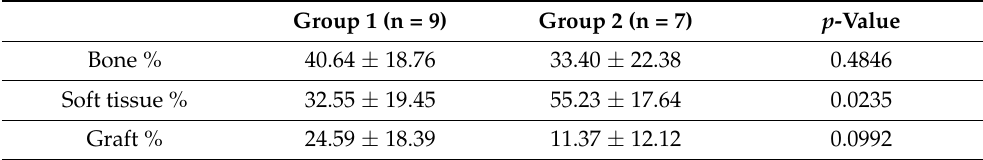
Table 2. Histomorphometric analysis between